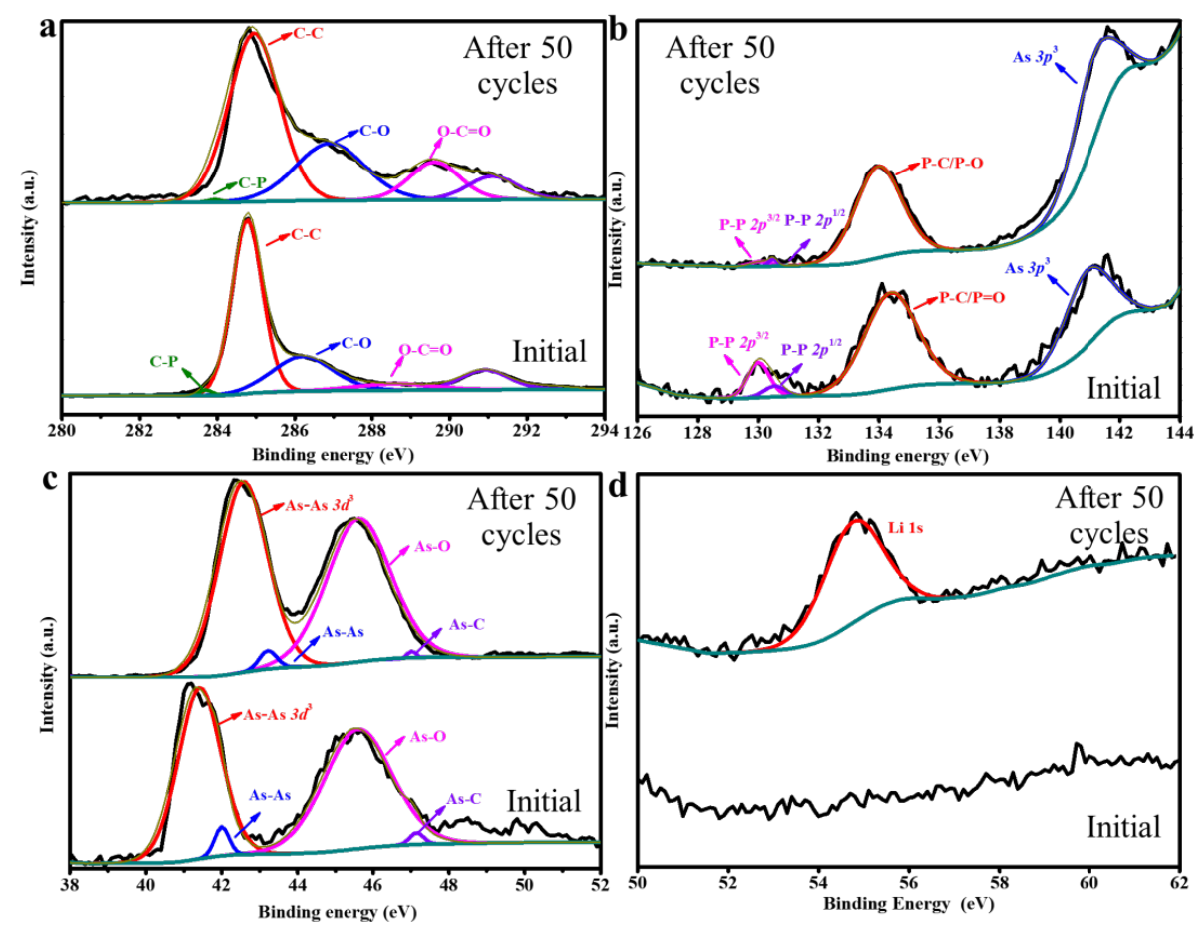
Figure 3. XPS spectra of GO/B-AsP/CNTs before and after charge-discharge cycles. ( a ) C 1s, ( b ) P 2p, ( c ) As 3d, and ( d ) Li 1s.